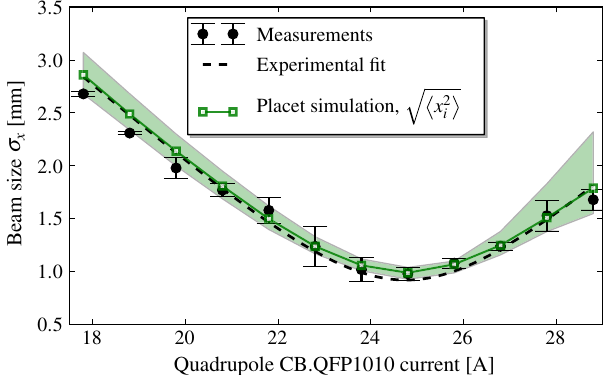
FIG. 11. Measured and simulated horizontal quadrupole scan at the end of the TBL. The measurement is an average of four quadrupole scans, and a parabola was fitted to the data. The curve for the simulations has a green band representing the uncertainty in the Twiss parameters and emittance measured at the beginning of the